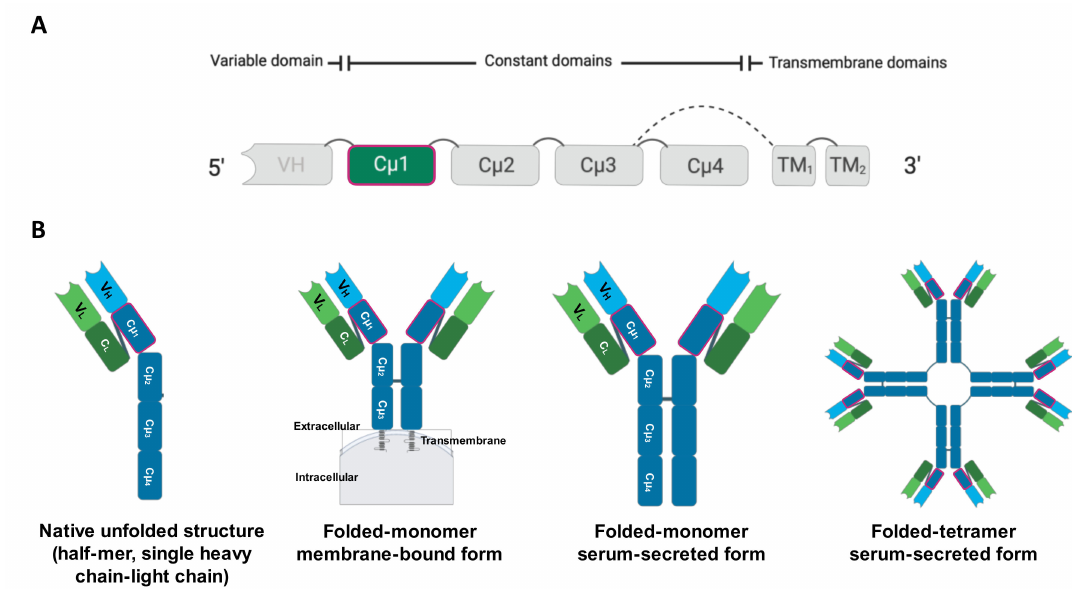
Figure 1. General molecular structure and alternative splicing pattern of the IgM heavy chain in teleost fish ( A ). Comparison among teleost immunoglobulin isoforms, which are generally expressed in membrane-bound form (B cell receptor) or as a secreted native unfolded-half-mer structure, folded-monomer, or folded-tetramer in the serum ( B